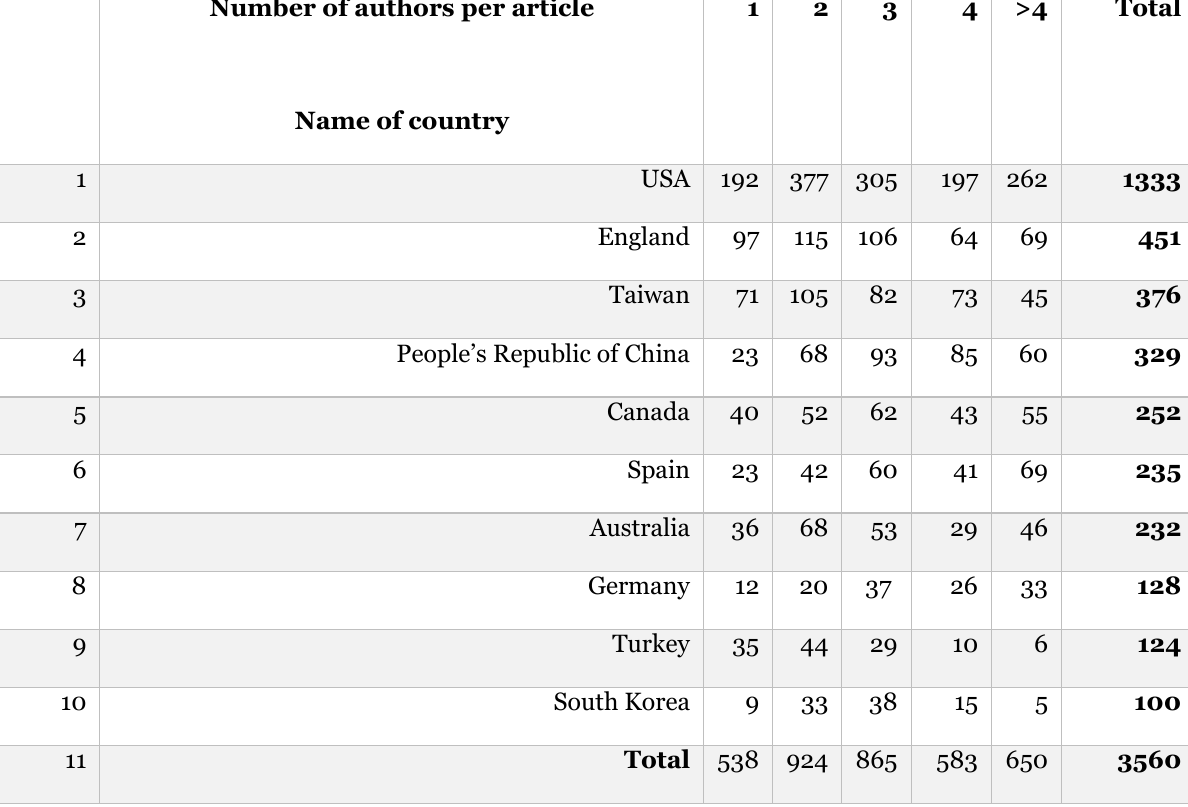
Collaboration Rate of Authors from Countries Prolific in E-learning Publication